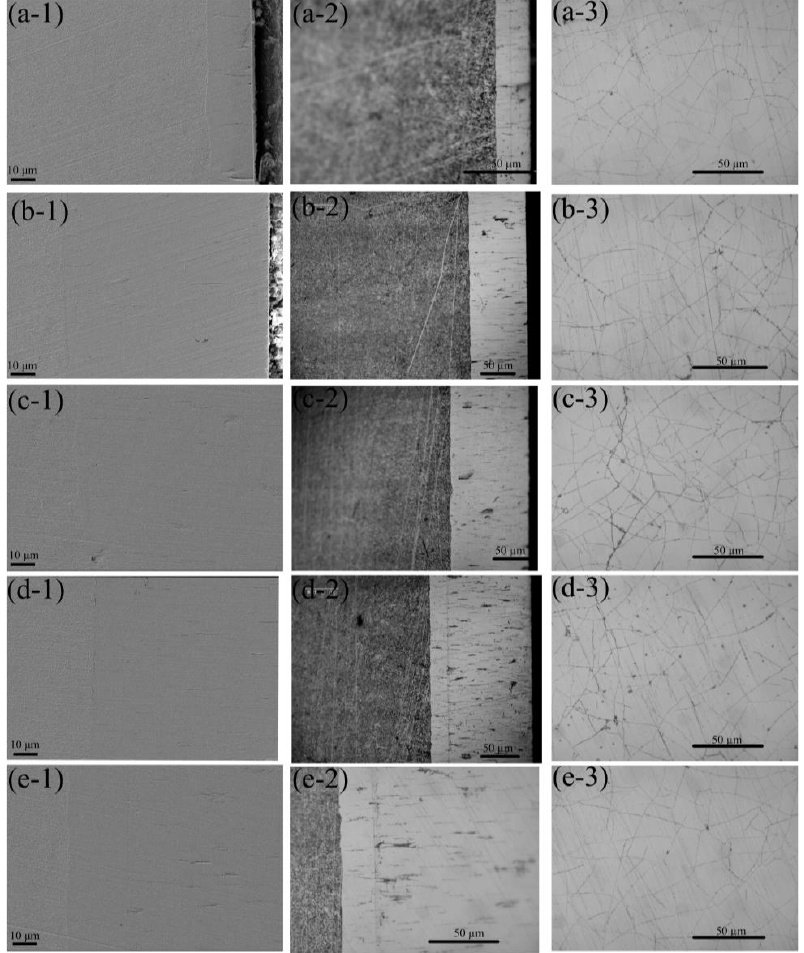
Figure 6. Morphology of c ross-section and cracked coating surface deposited at ( a-1 – a-3 ) 5 A/dm 2 , ( b-1 – b-3 ) 10 A/dm 2 , ( c-1 – c-3 ) 15 A/dm 2 , ( d-1 – d-3 ) 20 A/dm 2 , and ( e-1 – e-3 ) 25 A/dm 2 .